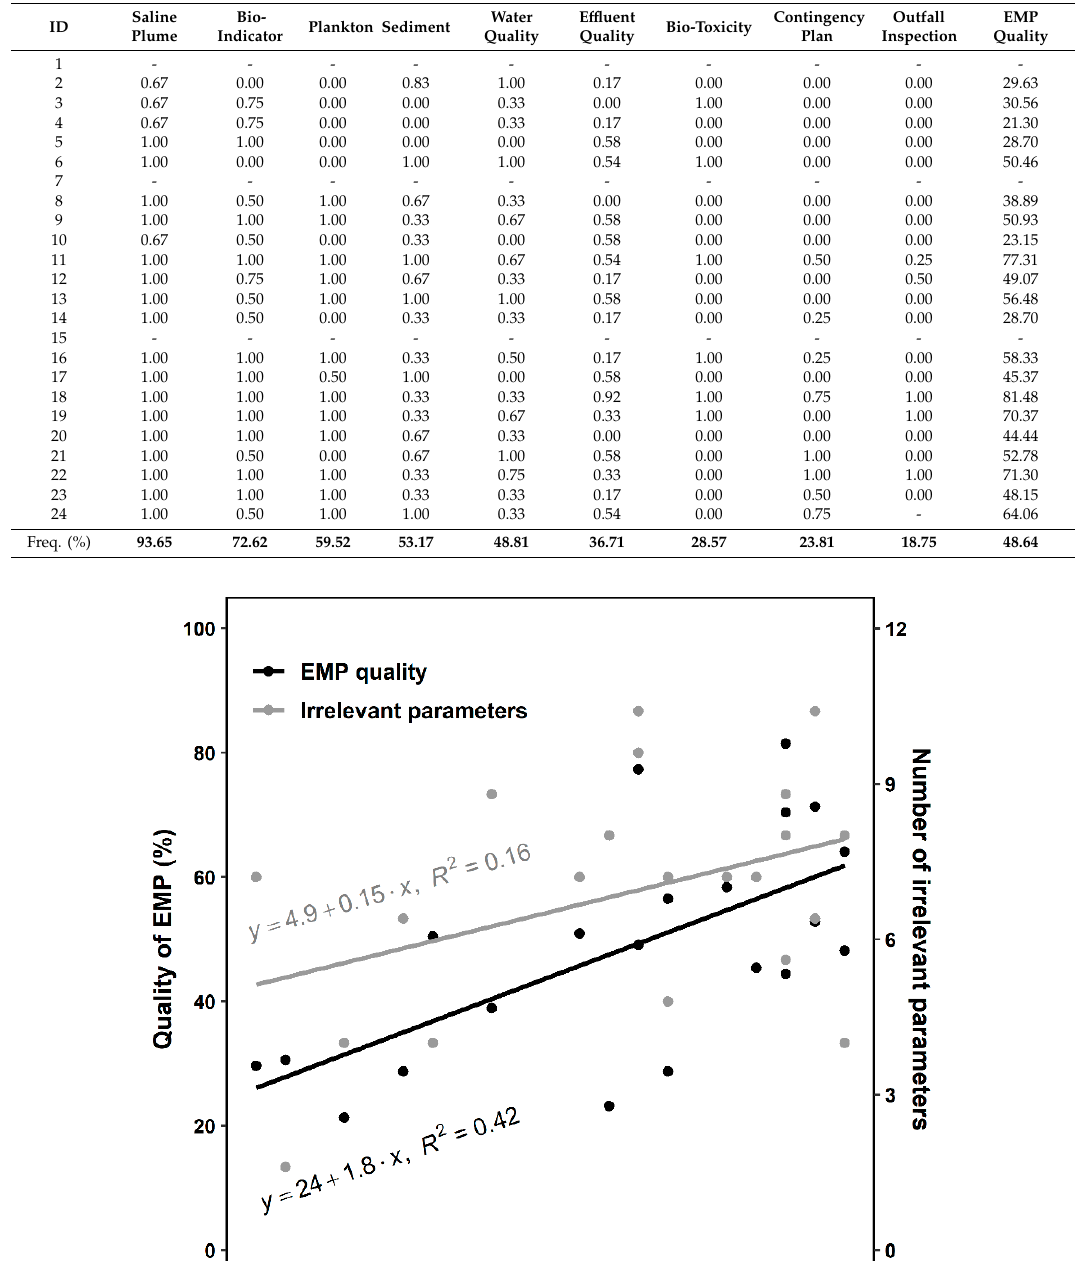
Table 3. Assessment of the 21 EMPs using the parameters defined for the correct control and mitigation of the impacts caused by SWRO plants on the marine environment.